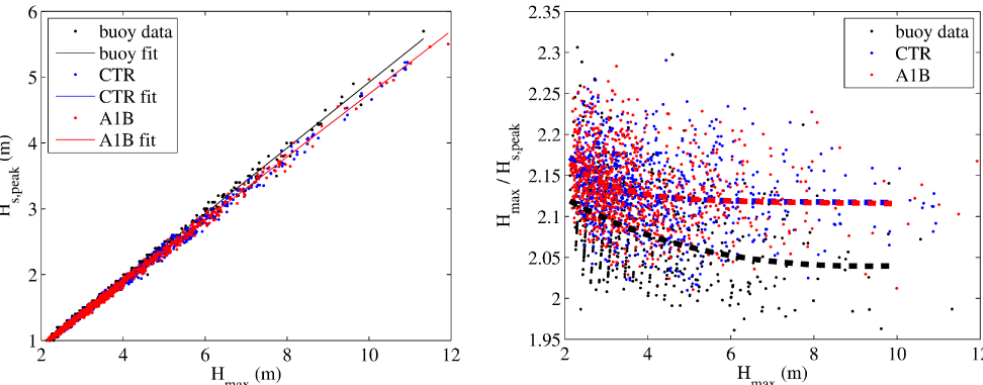
Fig. 6. Borgman’s analysis of the storms at the Ortona buoy (black: observed; blue: CTR run; red: A1B run). Left: scatter plot of H max and H s,peak data. The linear fitting is superimposed to the collection of scattered points. Right: H max /H s,peak ratio with respect to H max for each storm. The exponential data fitting is superimposed (dashed line).